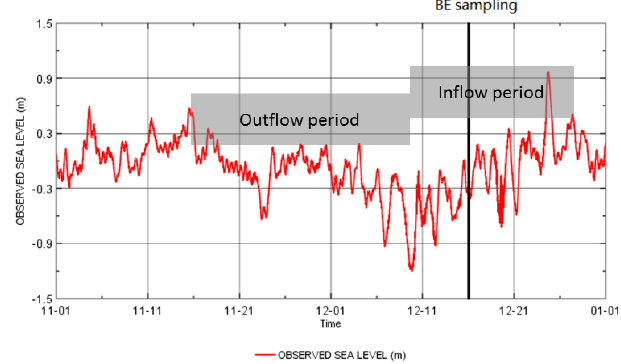
Figure 5. Sea level variations in November and December 2014. The black line indicates the occurrence of BE sampling in Decem- ber